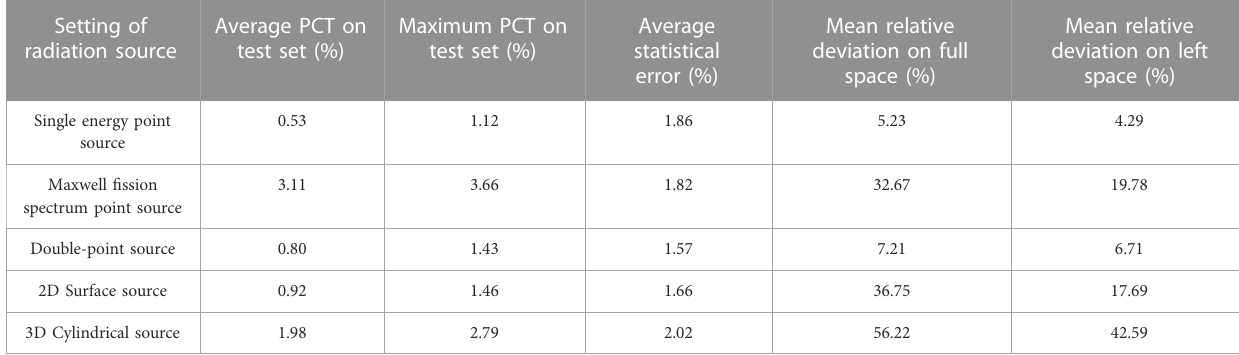
TABLE 2 Summary of reconstruction of radiation fi eld by MLP neural network. Setting of radiation